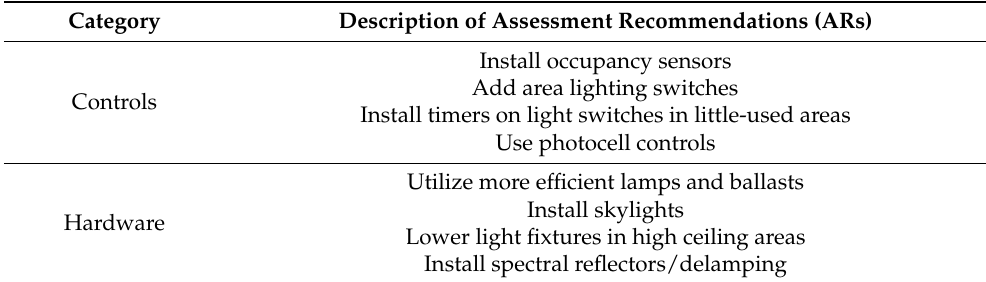
Table 1. Examples of ARs for increasing the efficiency of lighting systems.